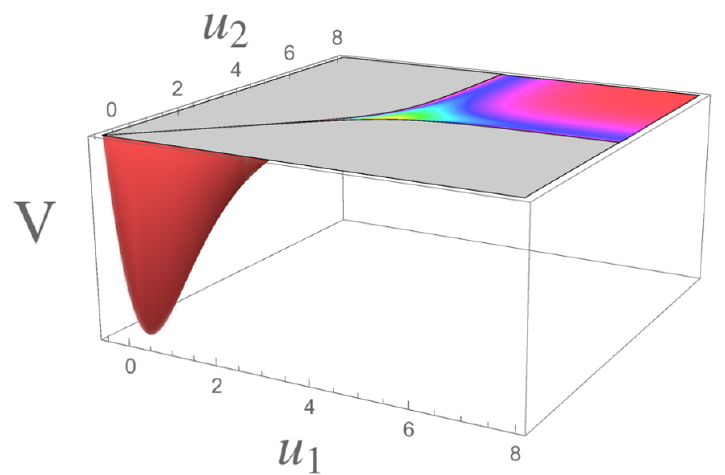
Figure 9 . The potential of the canonical (cid:12)elds u i for M = 500 m . The height of the potential is shown in units m 2 . The colored area shows the part of the potential with V < m 2 ; the red area in the upper right corner shows the in(cid:13)ationary plateau asymptotically approaching V = m 2 . From there on, in(cid:13)ation continues when the (cid:12)eld rolls towards the narrow gorge along which the (cid:12)elds u 1 and u 2 coincide. This gorge is seen as a narrow diagonal cut beginning at the center of p p 2 M the (cid:12)gure. For ’ = ( u 1 + u 2 ) = 2 > 2 log 8 , the gorge is wide, as seen in the right 3 m